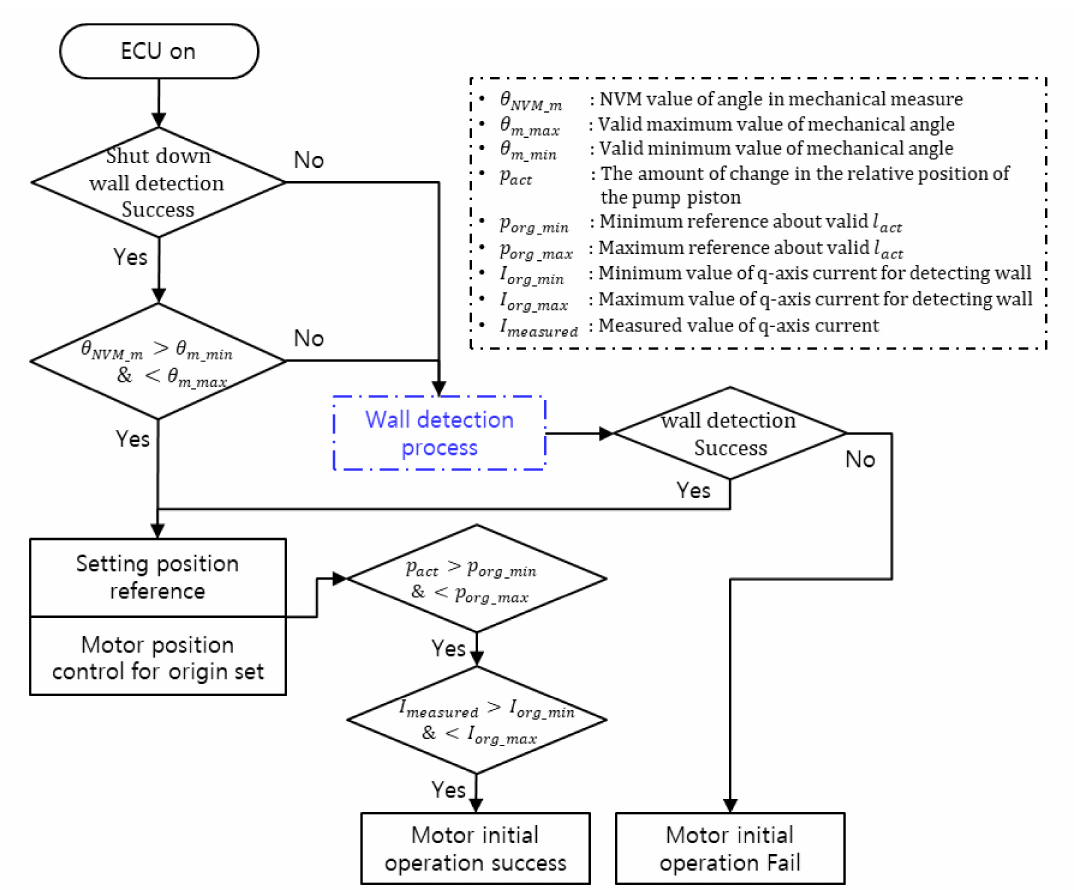
Figure 5. Flowchart of the proposed motor initial operation with the EHB system ECU on.